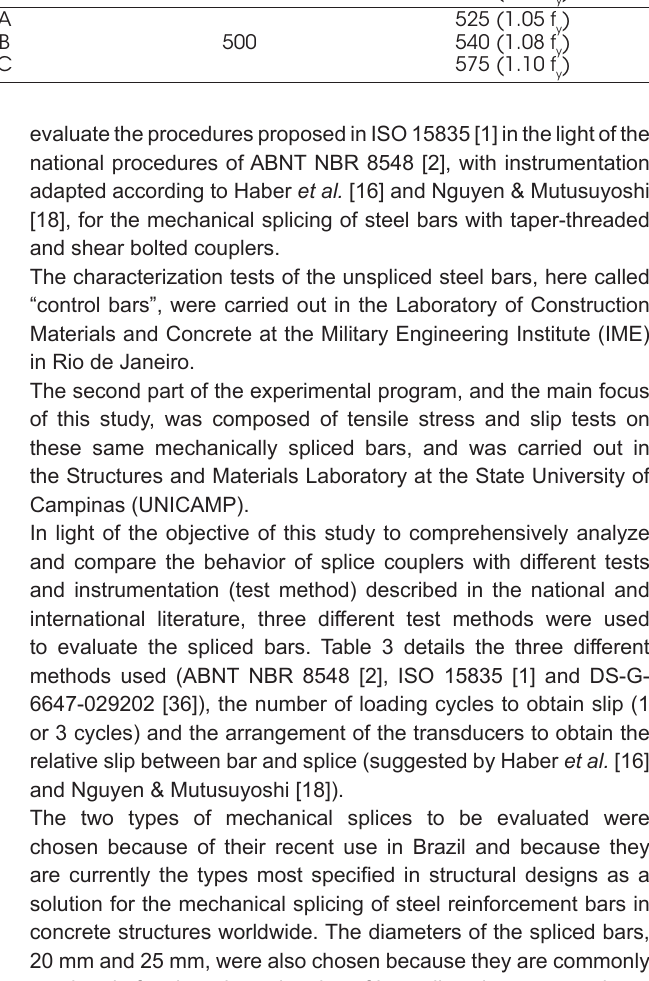
Table 2 International standard f Country